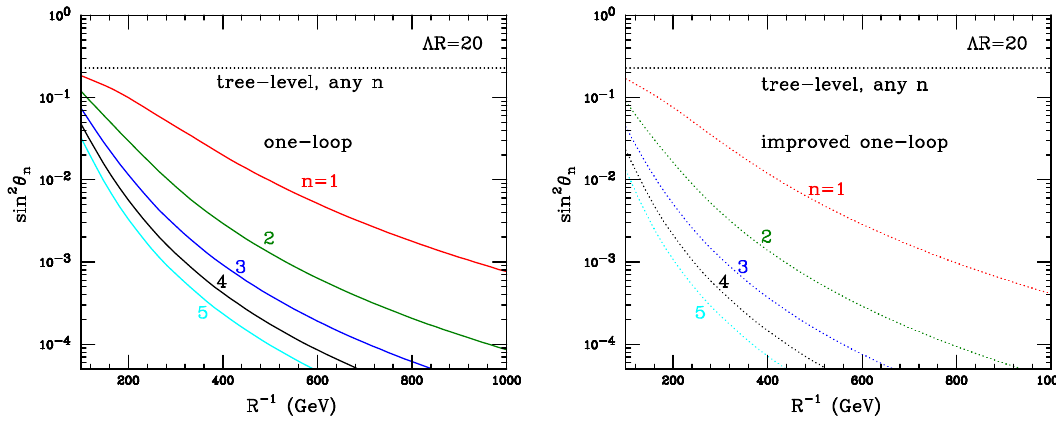
Figure 10 . Dependence of the Weinberg angle (cid:18) n for KK levels ( n = 1 ; (cid:1) (cid:1) (cid:1) ; 5) on R (cid:0) 1 for (cid:3) R = 20 with (right) / without (left) (cid:12)nite